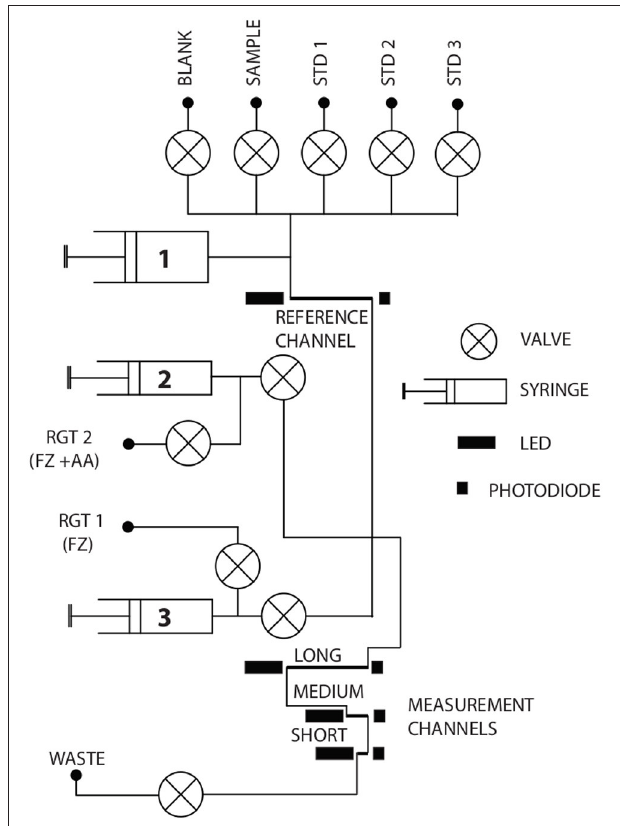
FIGURE 1 | Schematic of the microfluidic manifold illustrating the design of the chip. Absorbance measurements are conducted in three optical cells of different length, labeled as long (91.6mm), medium (34.6mm), and short (2.5mm). The syringe pumping unit comprises a large barrel (1) with 9.71mm ID for blank, sample and standards and two small barrels (2 and 3) with 3.28mm ID for the FZ/ascorbic acid mixture (RGT 2) and the FZ reagent (RGT 1). Solenoid valves are used for fluidic